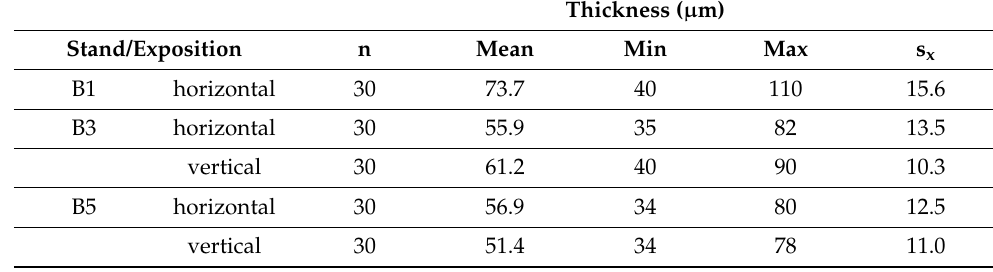
Table 22. Thickness of corrosion products.